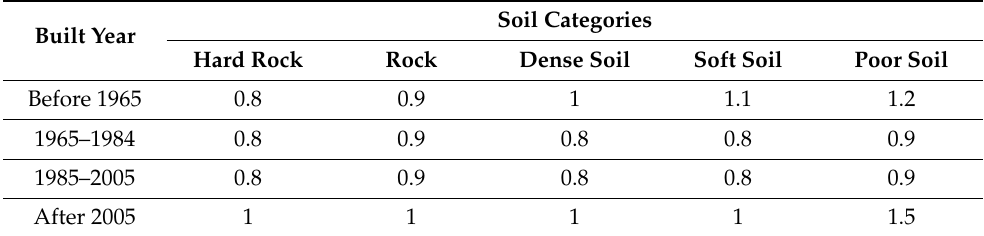
Table 4. Matrix used to determine criterion C (adapted from NRC1992 and NBCC2005).